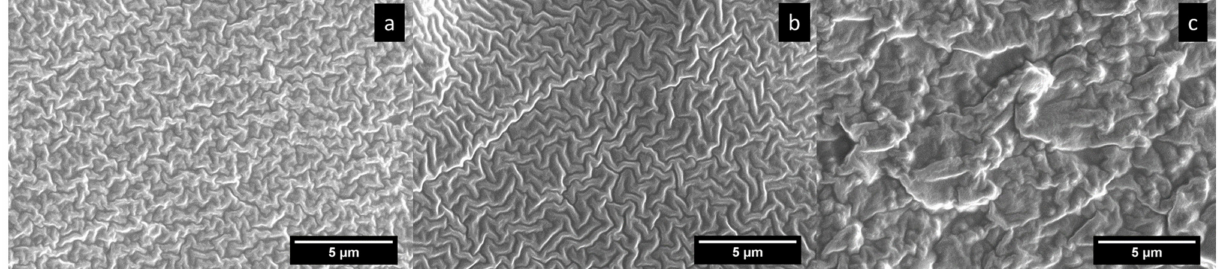
Figure 2. Cross-section morphology of samples A1B1 ( a ), A2B1 ( b ), and A1B2 ( c ); 5 µ m